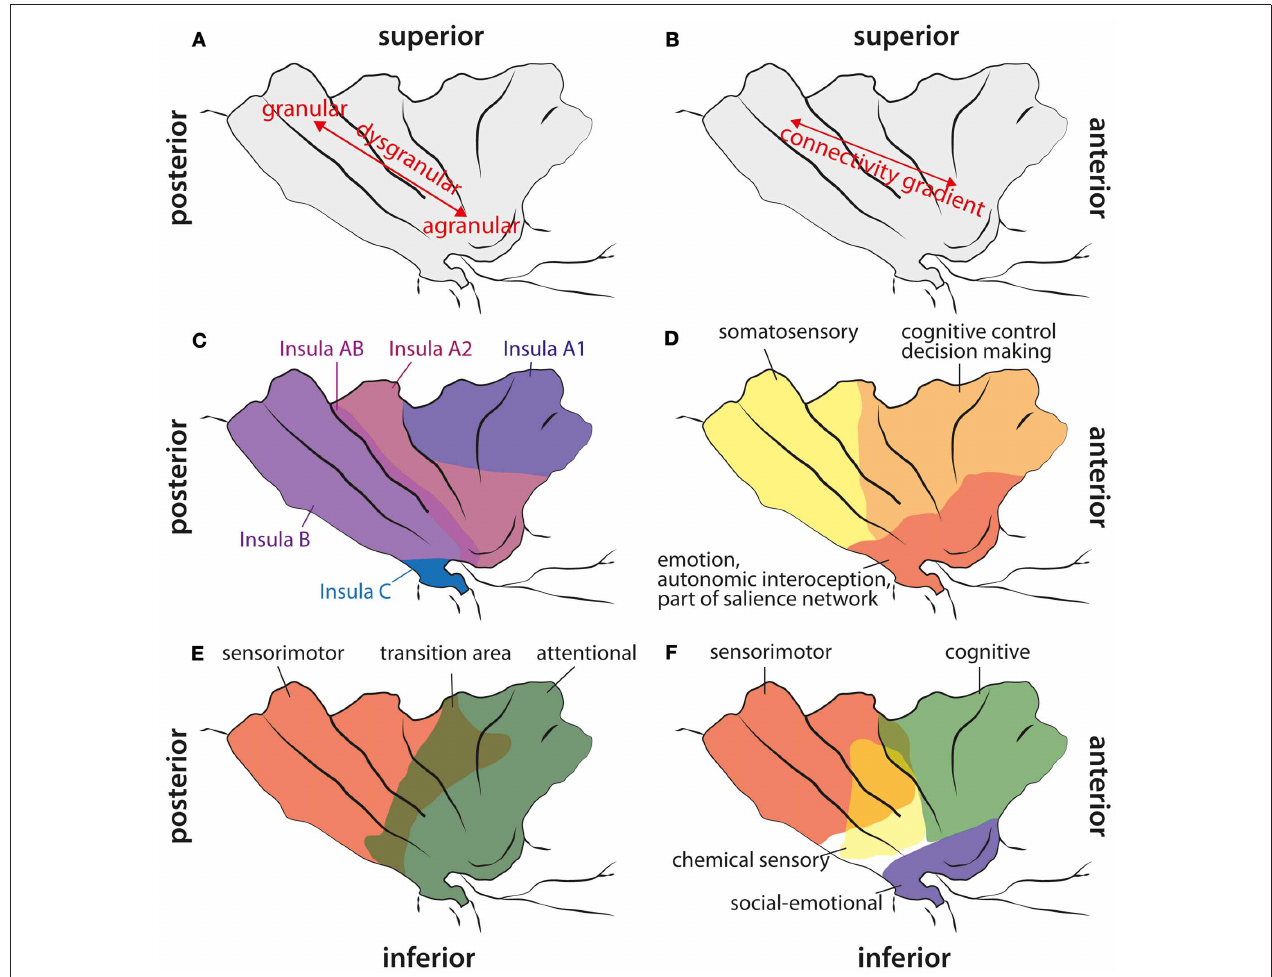
FIGURE 1 | Cytoarchitectonic, structural connectivity, and functional maps of the human insula. (A) Cytoarchitectonic gradient from agranular cortex in the anterior inferior insula via dysgranular cortex to granular cortex in the posterior part of the insula. (B) Structural connectivity gradient in the insula according to Cerliani et al. (2012). Unlike in other brain areas (e.g., premotor cortex), they did not find any clear border between insula regions based on the structural connectivity profile; instead, they reported a gradual change in connectivity patterns from anterior to posterior insular areas. (C) Cytoarchitectonic map adapted from Von Economo and Koskinas (1925). They did not find any agranular areas